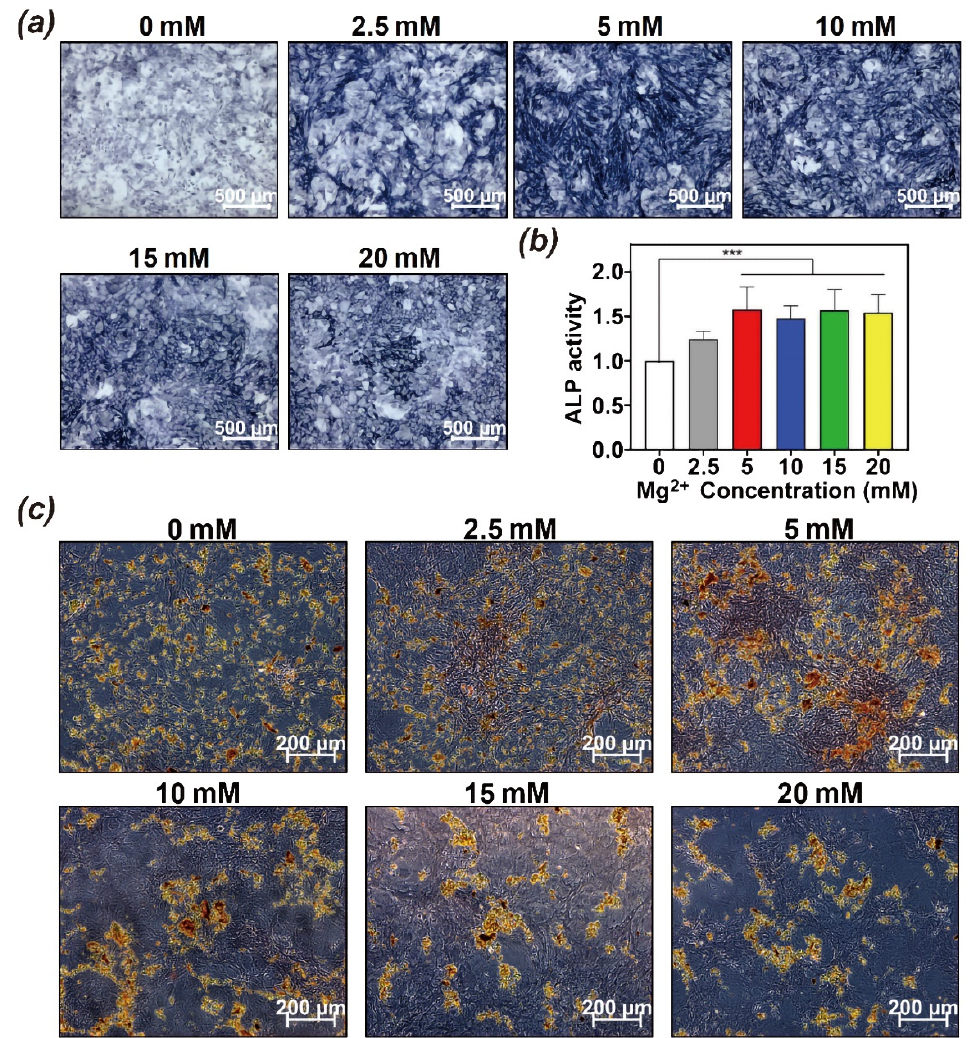
Figure 4. In vitro effect of Mg 2+ on BMSCs osteogenic differentiation; ( a ) ALP staining and ( b ) quantification of BMSCs exposed to different concentrations of Mg 2+ for 7d; ( c ) ARS staining of BMSCs exposed to different concentrations of Mg 2+ for 21d; *** p < 0.001.